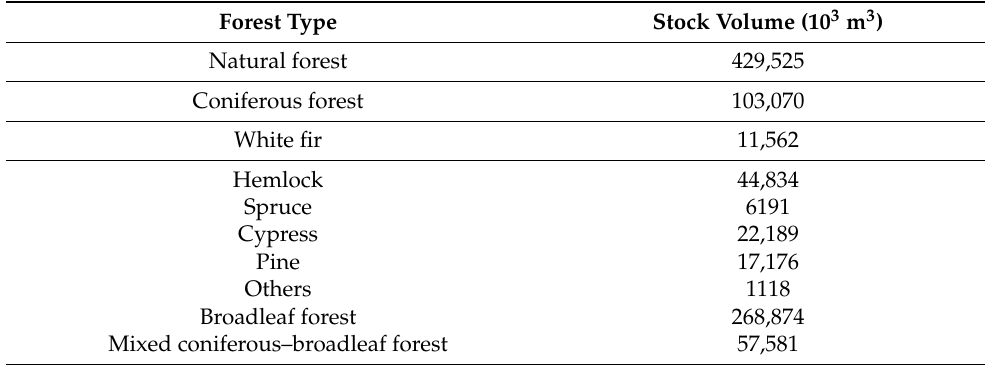
Table 2. The forest types and their stock volumes in Taiwan 1